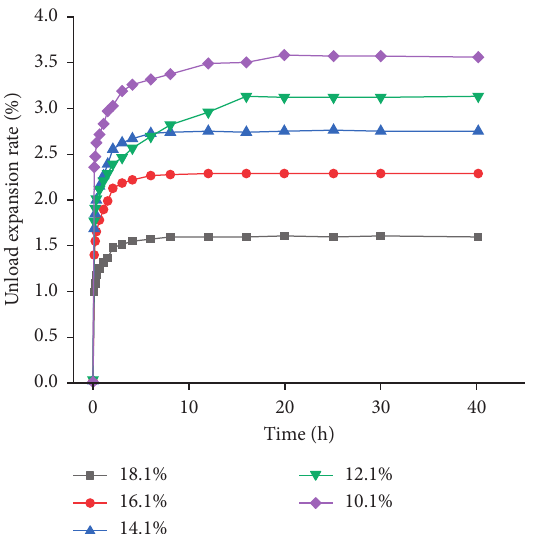
Figure 14: Curve of the loaded expansion rate of undisturbed soil.